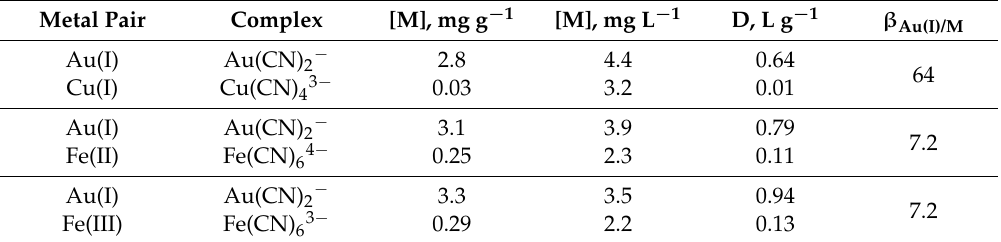
Table 5. Adsorption of different metal-cyano complexes and selectivity of the